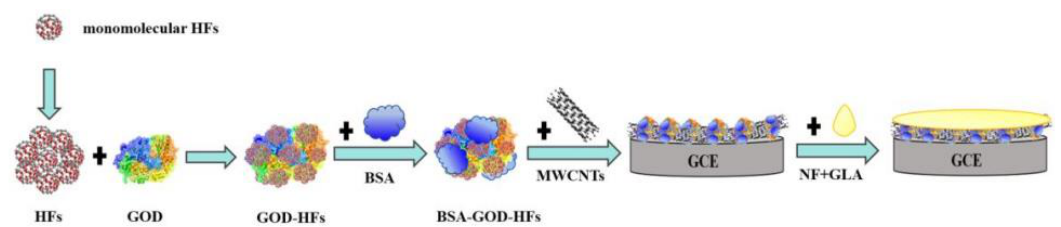
Figure 1. Preparation process of modified